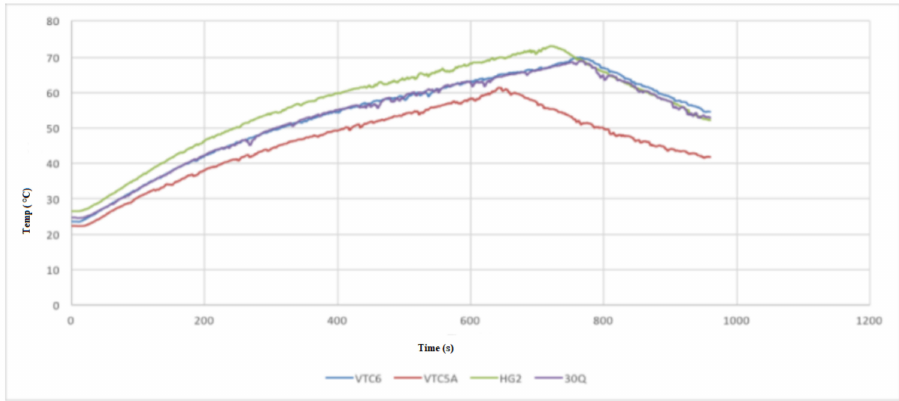
Figure 5. Single cell tests: temperatures from 15 A discharge with no cooling.